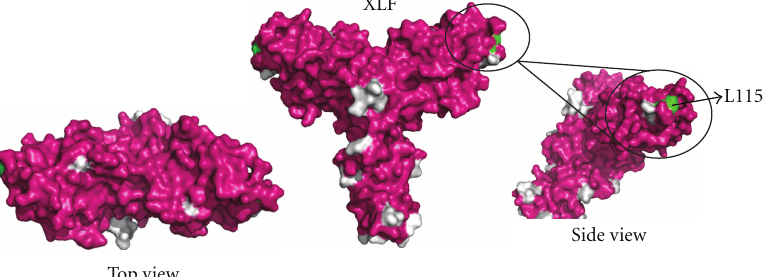
Figure 16: Surface views of XLF 1–233 (PDB code: 2QM4). Residue L115, which is important for XLF-XRCC4 binding is labeled in green. Nonessential residues for XLF-XRCC4 interaction I105, E111, E169, L174, R178, L179, E185, and I195 and residues after 224 are labeled in grey